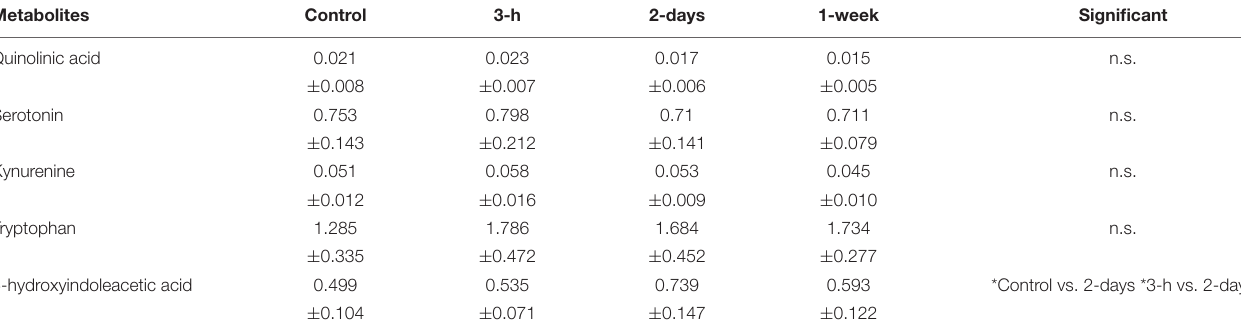
TABLE 6 | Concentrations of tryptophan derivates in CSF samples using targeted HPLC-MS method. Metabolites